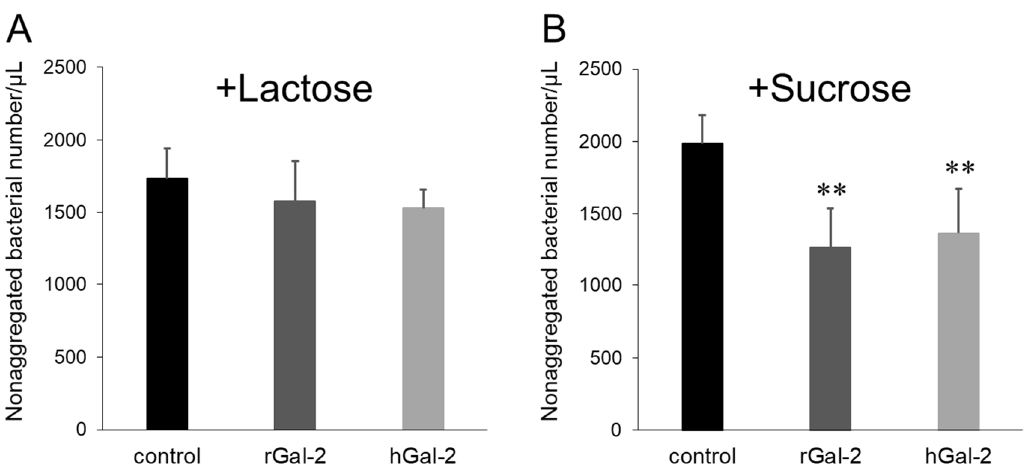
Figure 2. Inhibition of Gal-2 induced H. pylori aggregation by competitive sugar, lactose. ( A ) Number of nonaggregated bacteria under the lactose coexistence condition. ( B ) Number of nonaggregated bacteria under sucrose coexistence condition. Concentration of Gal-2 added was 93.9 µg/mL; concentrations of lactose and sucrose were 0.1 M. Black, dark gray, and light gray bars represent the control (without Gal-2), rGal-2, and hGal-2, respectively. Each bar represents mean ± SD from five image samples. **, p < 0.01 by Dunnet’s test (vs. control).